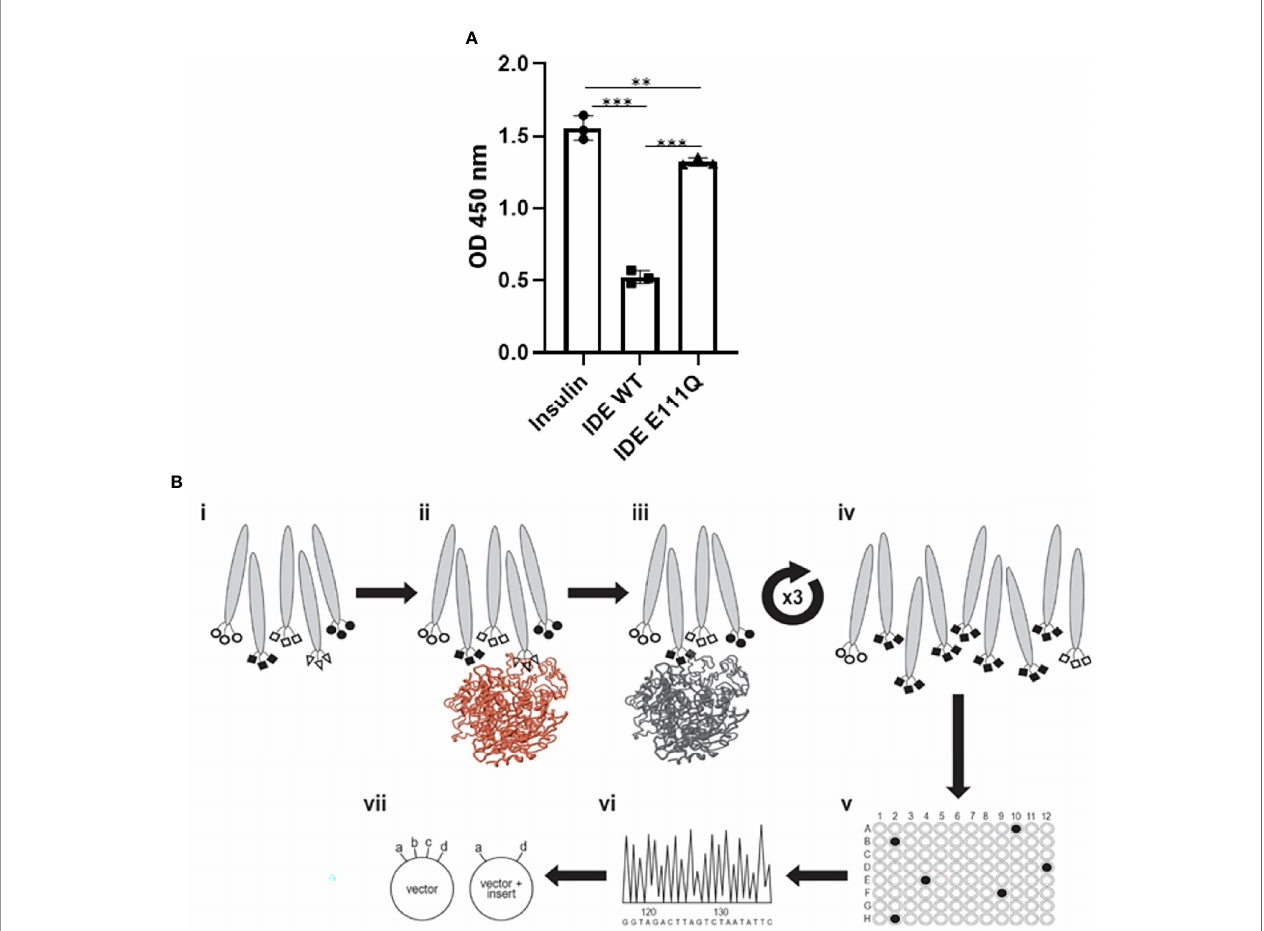
FIGURE 1 | Activity of puri fi ed rhIDE wild-type and inactive mutant (E111Q) and their utilization in the antibody discovery process. (A) IDE activity assay: incubation of 1.5 µg/L human insulin with PBS (insulin, 1.5 m g/L) or 12 µg/ml rhIDE WT or E111Q for 2 h at 37°C. Residual insulin was later analyzed using Mercodia ultrasensitive mouse insulin ELISA. Results detected on an ELISA plate reader at 450 nm. The results are presented as mean ± SEM (n = 3). **p < 0.01; ***p < 0.001. One-way ANOVA with Bonferroni correction. (B) Scheme of the antibody discovery pipeline that was used to obtain rhIDE-binding antibodies: (i) antibody phage display library 2 × 10 9 antibody clones used as input for the fi rst panning cycle; (ii) depletion: capture on mutant rhIDE (colored brown); (iii) positive selection: capture depleted phages on WT rhIDE; (iv) washed to remove unbound phages, recovered the phages that bound rhIDE, and ampli fi ed them by infecting E. coli and preparing an enriched population of rhIDE binders to be used as input for the subsequent panning cycles. Repeated three times to obtain a phage population dominated by rhIDE binders; (v) identi fi ed phages that bind WT rhIDE by monoclonal phage ELISA; (vi) identi fi ed the antibody coding sequences by sequencing of the DNA recovered from monoclonal phages that bind WT rhIDE; (vii) cloned the antibody coding sequences from the phages that bind WT rhIDE to an antibody expression vector to produce soluble puri fi ed